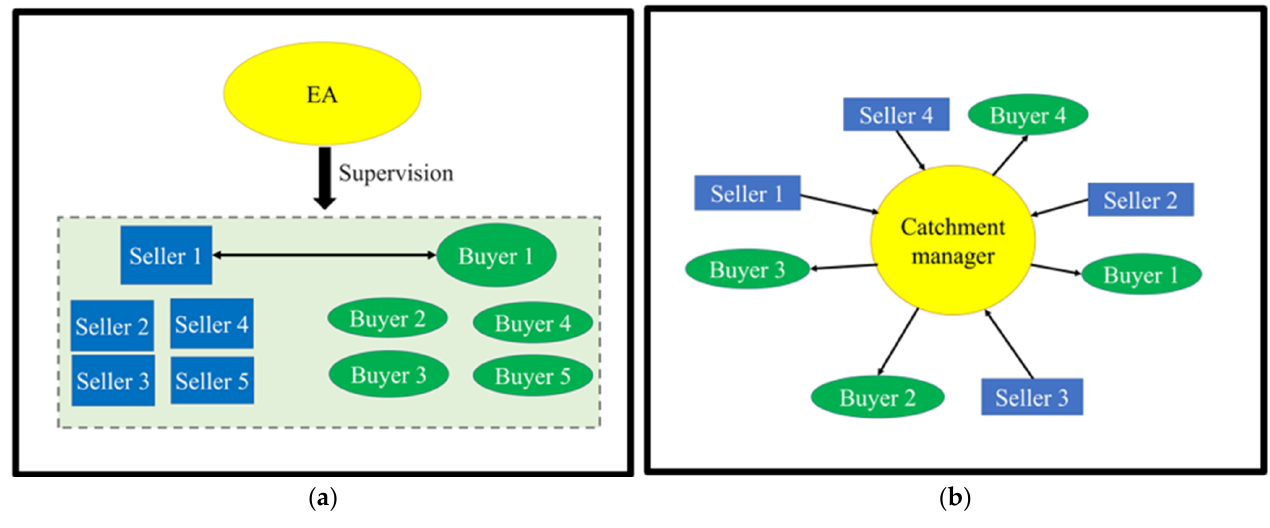
Figure 3. The current trading system in the UK [28]. ( a ) The model of improved pair-wise trading; ( b ) The model of the central pool method.